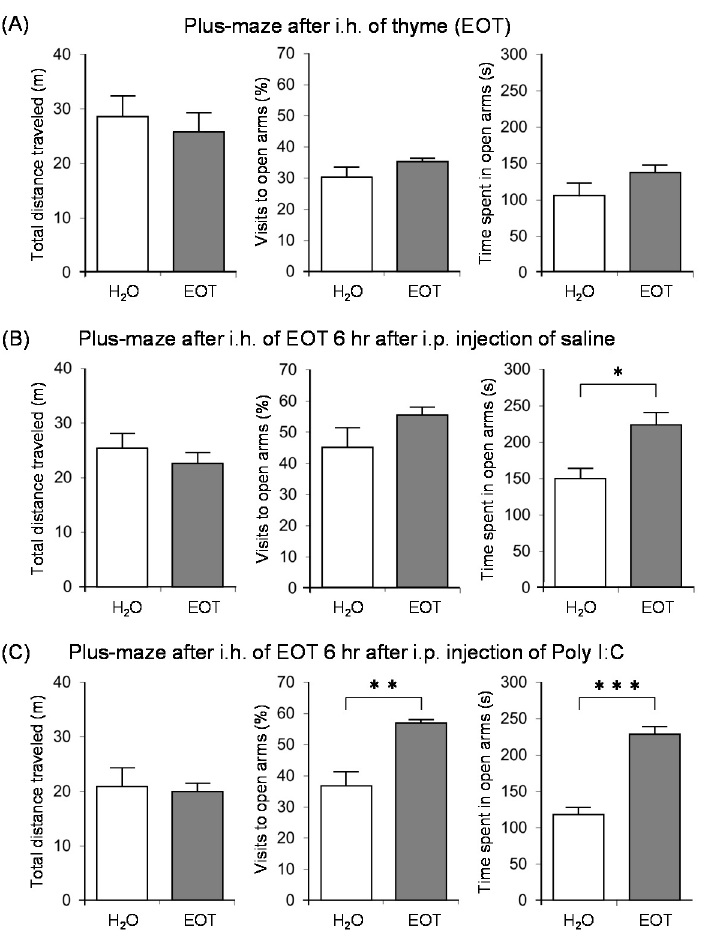
Figure 10. The effects of thyme on mouse behavior. ( A ): Elevated plus-maze test immediately